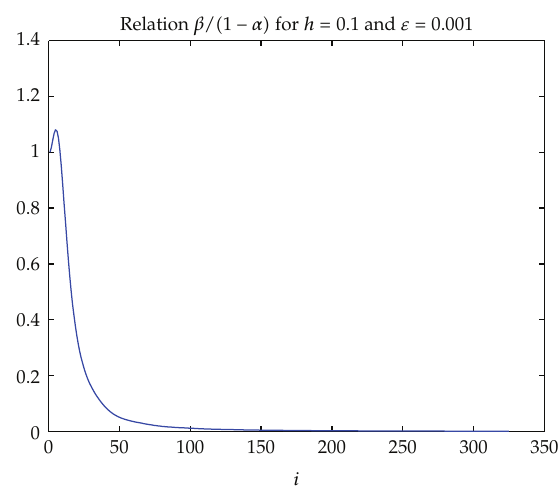
Figure 5: Ratio β/ (cid:2) 1 − α (cid:3) of coe ffi cients for ε (cid:8) 0 . 001.